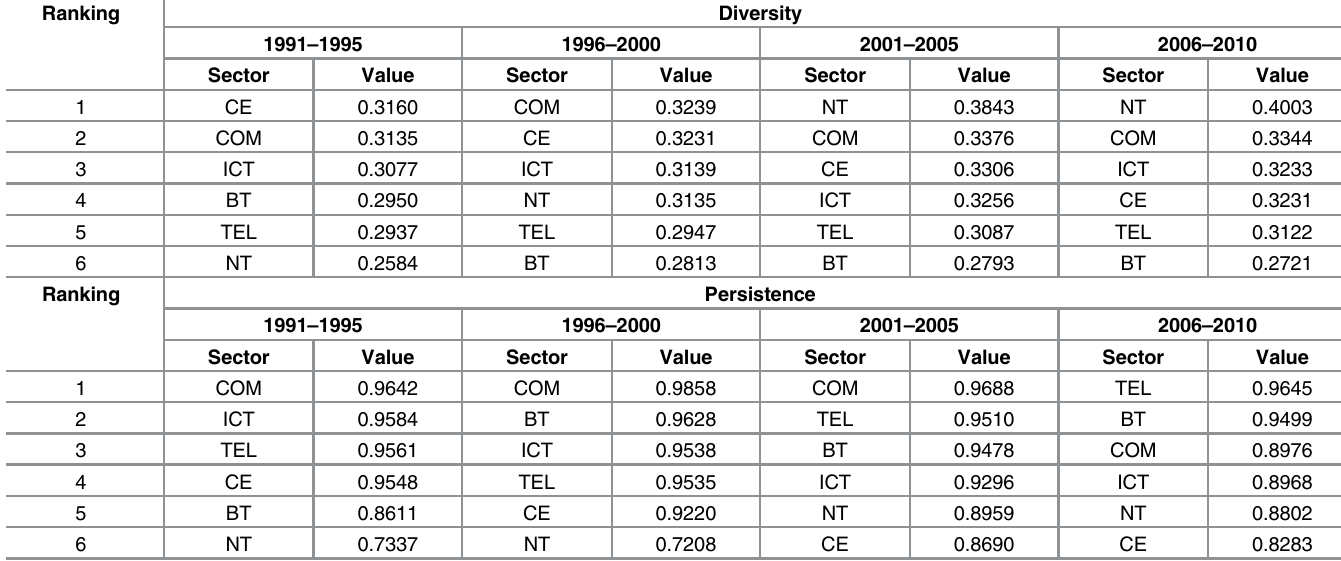
Table 8. Diversity and Persistence in ICT, BT, and NT Sectors in the